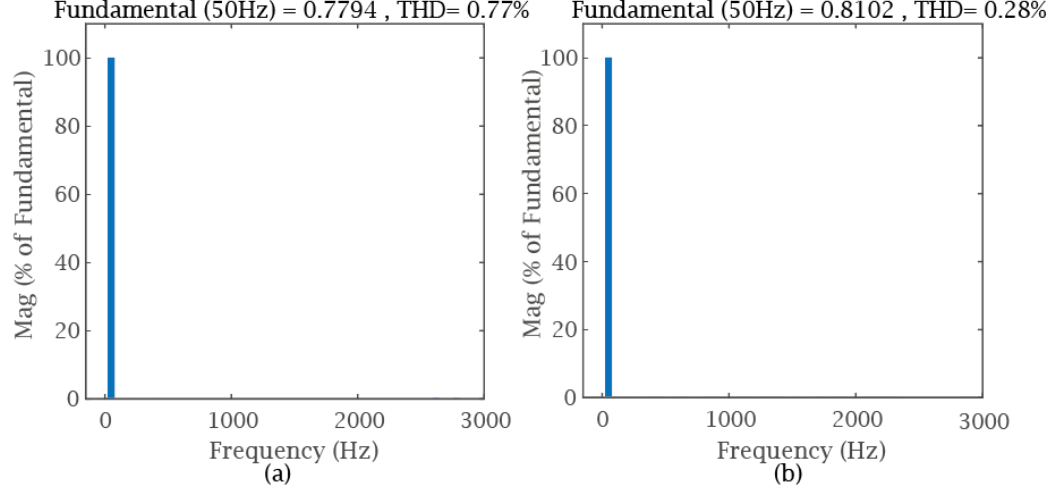
Figure 8. Stator current harmonic spectra: ( a ) Proportional-Integral (PI) controller; ( b ) STA-SOSM controller.